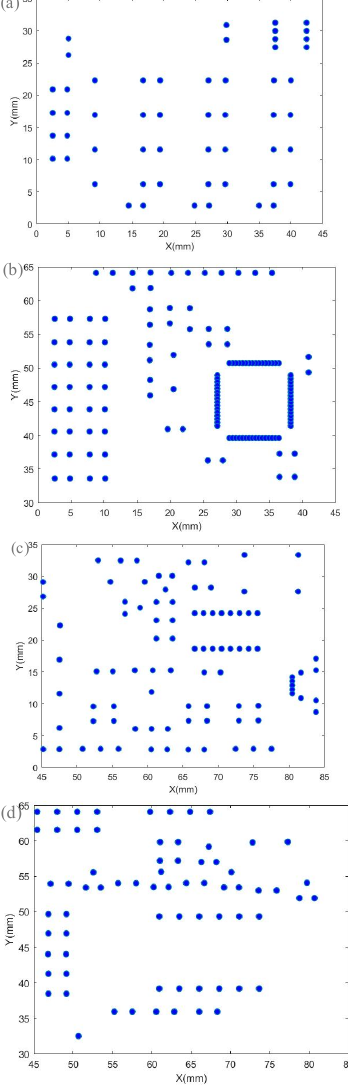
Figure 21. Distribution of solder joints belonging to each processing frame. ( a ) Processing frame 1, ( b ) Processing frame 2, ( c ) Processing frame 3, ( d ) Processing frame 4. ( b ) Processing frame 2, ( c ) Processing frame 3, ( d ) Processing frame